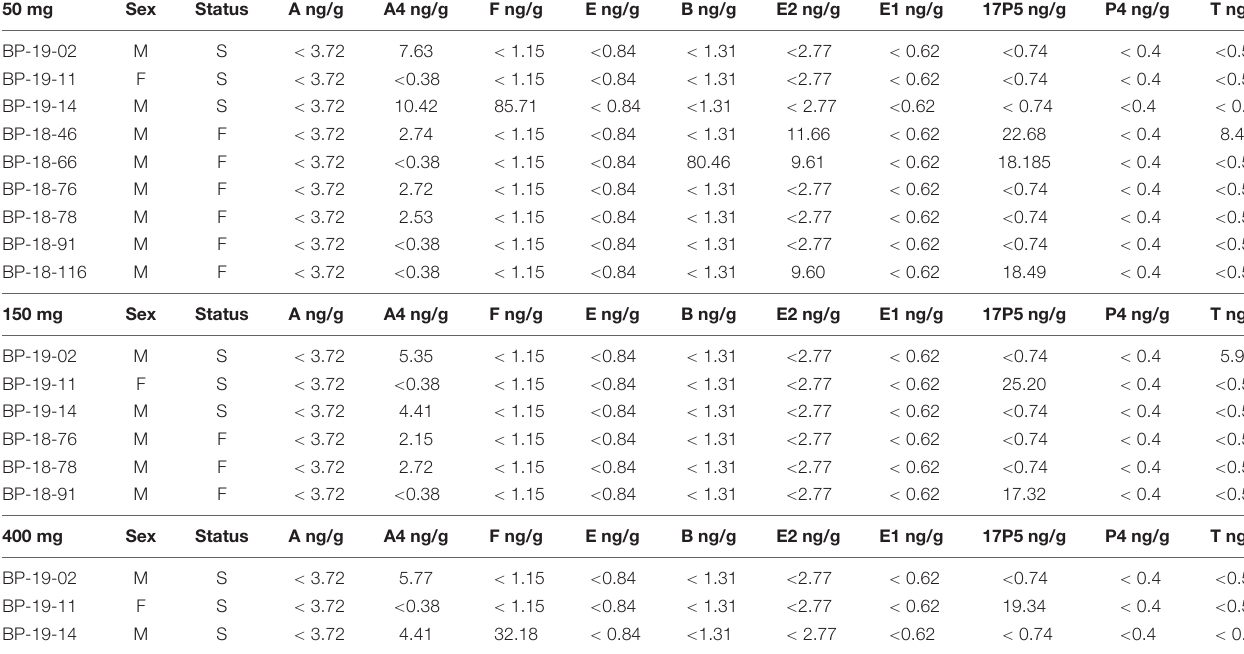
TABLE 4 | Hormone panel in 50, 150, and 400 mg fin whale samples F, M, and U correspond to female, male, and unknown, respectively. 50